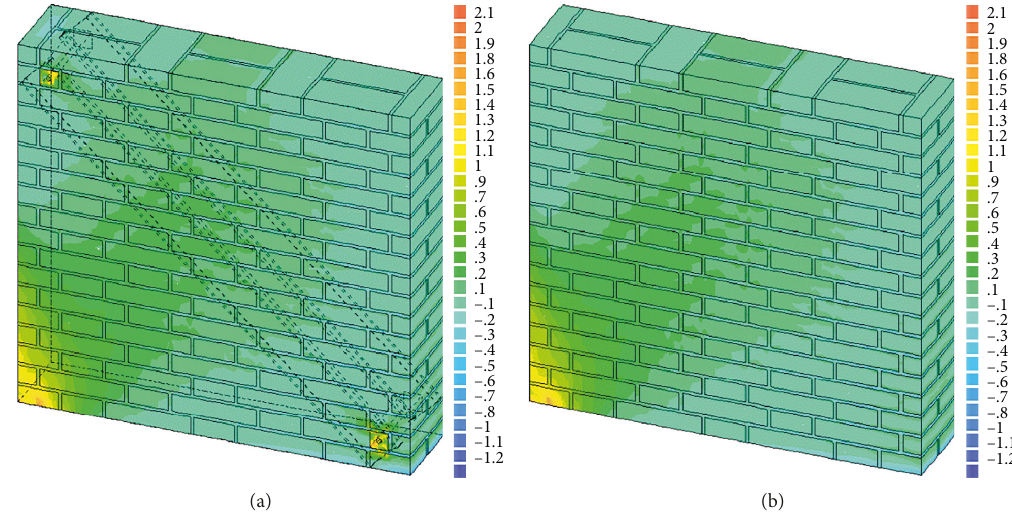
Figure 13: Contour plots of maximum principal stress σ load: 0.666mm, initial shear stiffness: 336N/mm 2 . (b) Peak load 378N/mm 2